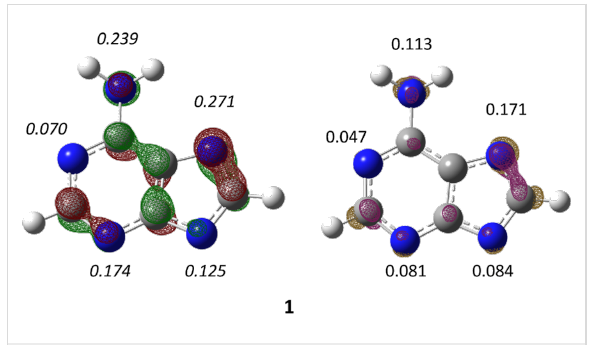
Figure 2: HOMO map of space distribution (left) of adenine anion ( 1 ) at the B3LYP/6-31+G(d) level of theory (MO = 35, isovalue = 0.08). Molecular orbital coefficients in italics. The isosurface plot of the condensed Fukui function f - (right) for the adenine anion (isovalue = 0.008) calculated with NPA